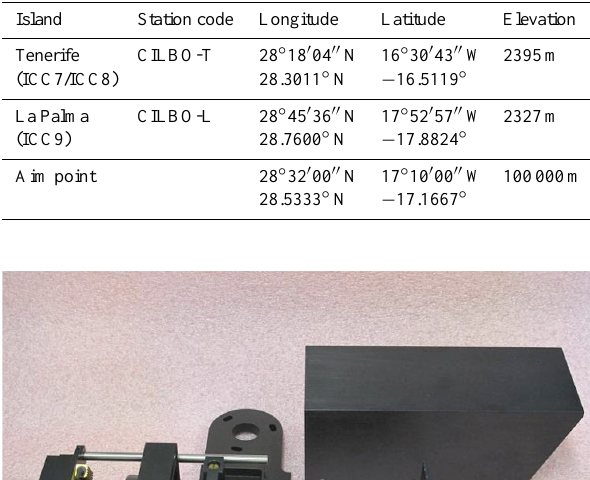
Table 1. Geographical positions of the two observation stations and the aim point.